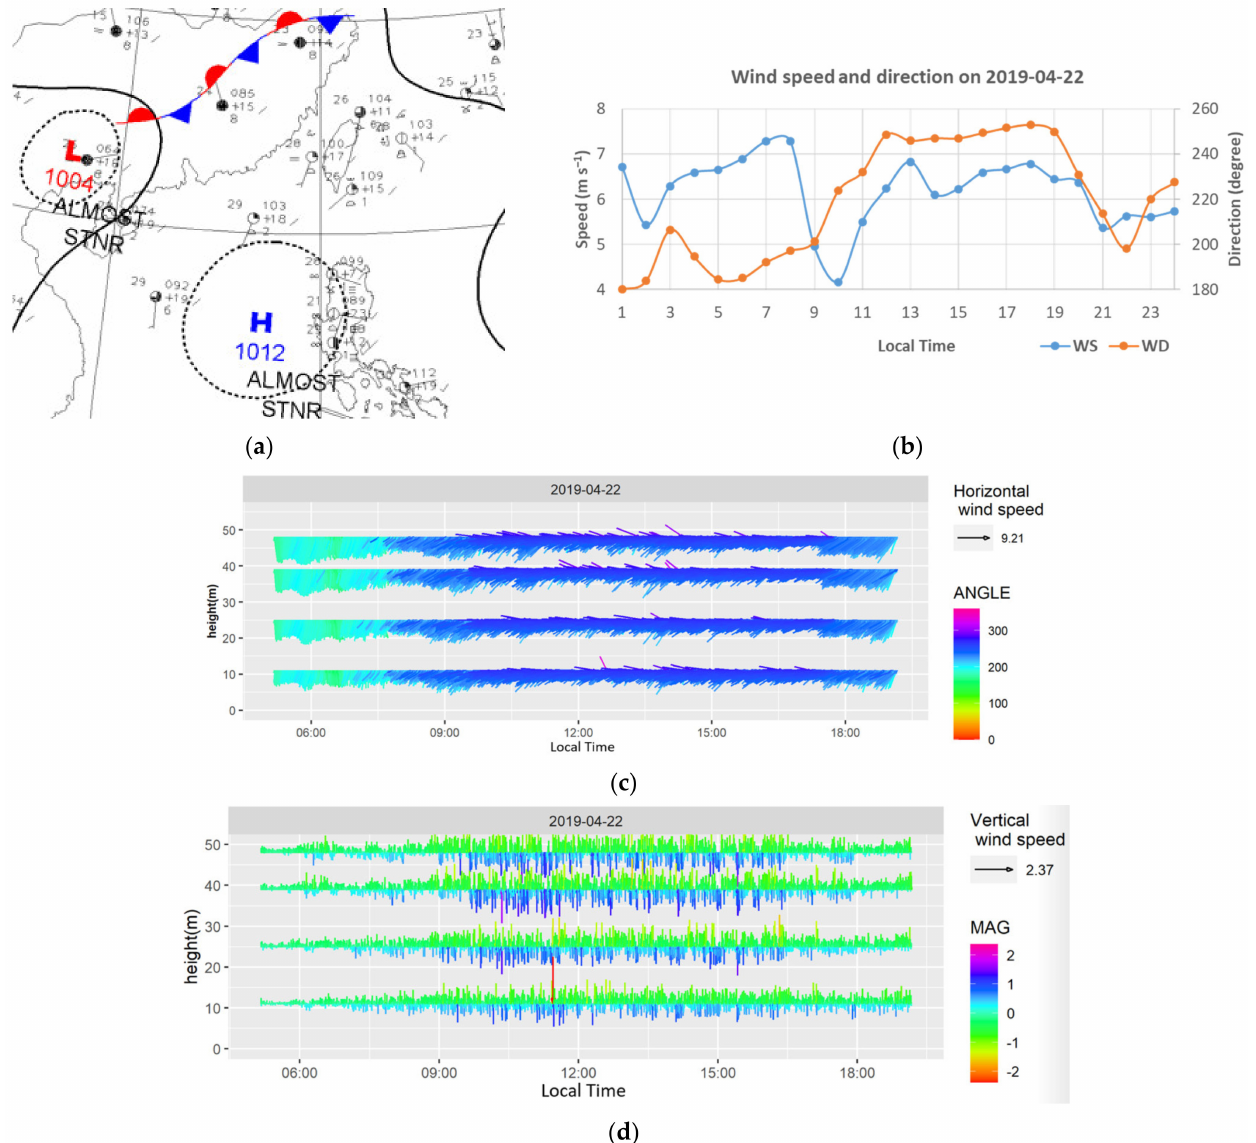
Figure 16. ( a ) The surface weather chart at 00:00 UTC on 22 April 2019 (backdoor sea breeze). ( b ) Wind Speed (WS) and Direction (WD) at 100 m height on 22 April 2019 (backdoor sea breeze). ( c ) Horizontal wind speed component of 11 m, 25 m, 39 m and 48 m on 22 April 2019 (backdoor sea breeze). ( d ) Vertical wind speed component of 11 m, 25 m, 39 m and 48 m on 22 April 2019 (backdoor sea